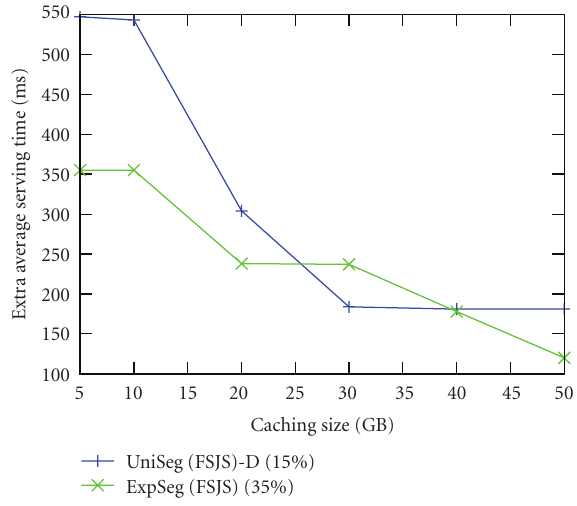
Figure 10: Two best strategies’